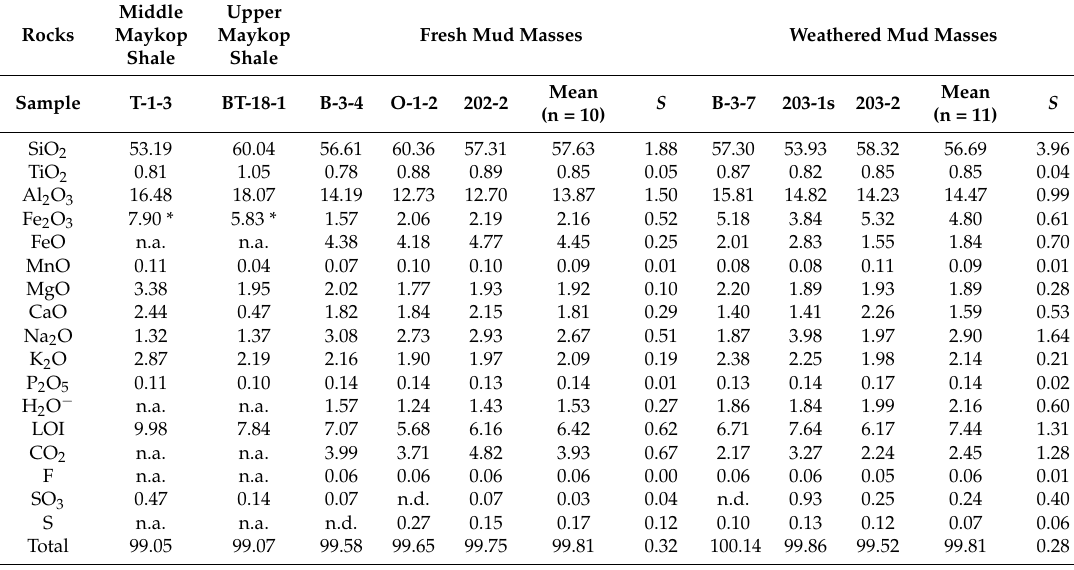
Table 1. Major element composition (in wt %) of representative mud masses from the Bulganak mud volcano area in comparison with Middle and Upper Maykop shales (Kerch-Taman MV province). Middle Upper Rocks Maykop Maykop Fresh Mud Masses Weathered Mud Masses Shale Shale Sample T-1-3 BT-18-1 SiO 2